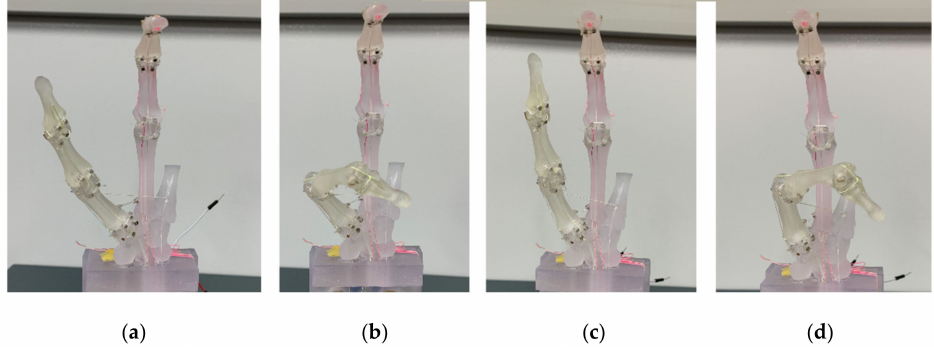
Figure 10. Thumb operation with multiple muscles. ( a ) Abduction position of CM; ( b ) IP/MP flexion with CM abduction (Video S6); ( c ) Adduction position of CM; ( d ) IP/MP flexion with CM adduction (Video S7).